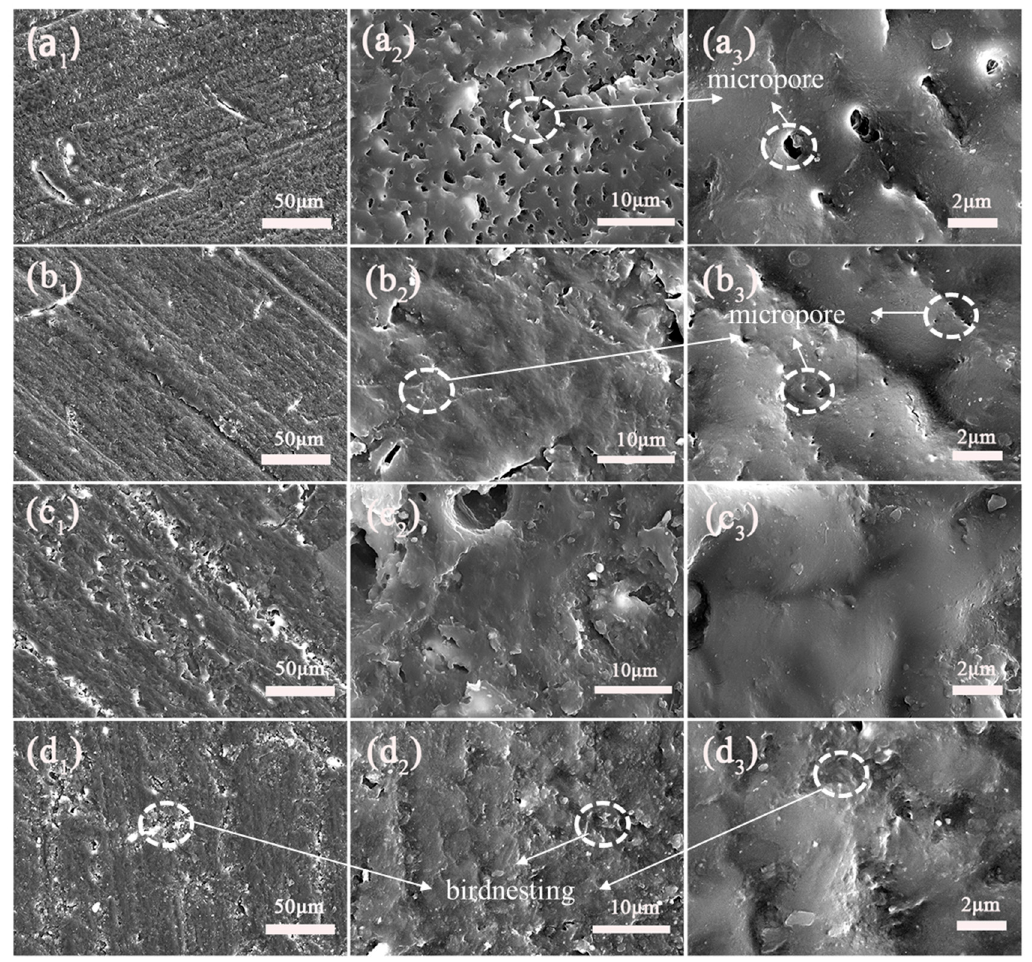
Figure 8. FE-SEM images of coating fracture surface at different magnification: ( a ) neat EP, pictures, ( b ) SiC-G@GO 0.5 , ( c ) SiC-G@GO 1 , and ( d ) SiC-G@GO 2 coatings.